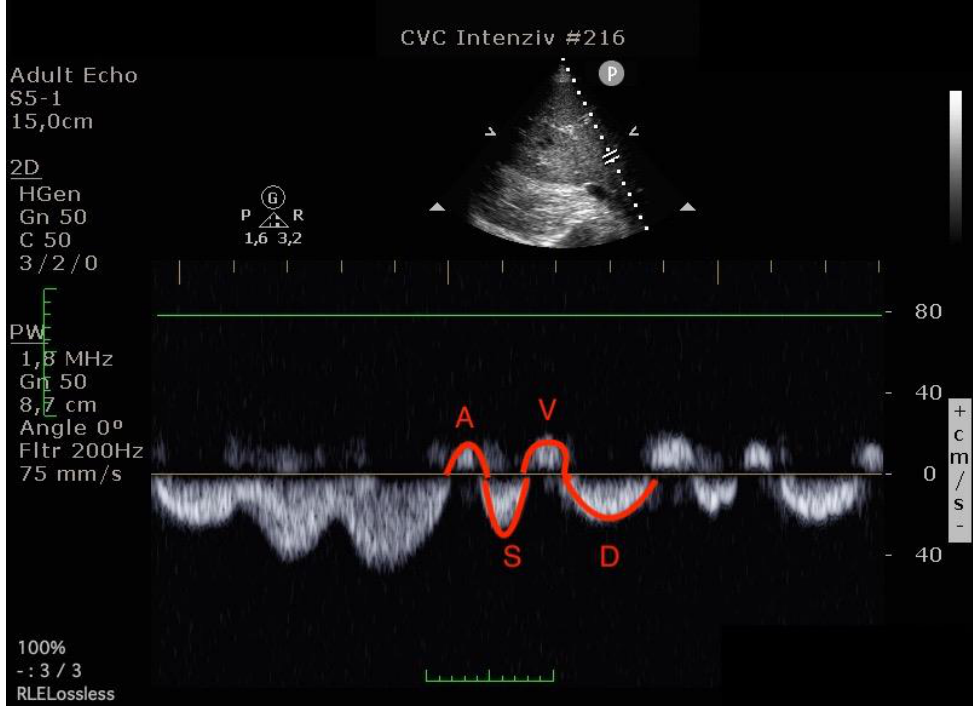
Figure 3. Hepatic venous flow pattern (The left image was done before operation, the right image in the postoperative 24th hour. On the postoperative image, A and V waves appear increased, while the S wave is smaller than the D wave. (A VTI: 6.47 to 8.29, S VTI: 12.31 to 8.12, V VTI: 5.98 to 7.98 and D VTI: 11.12 to 9.39).